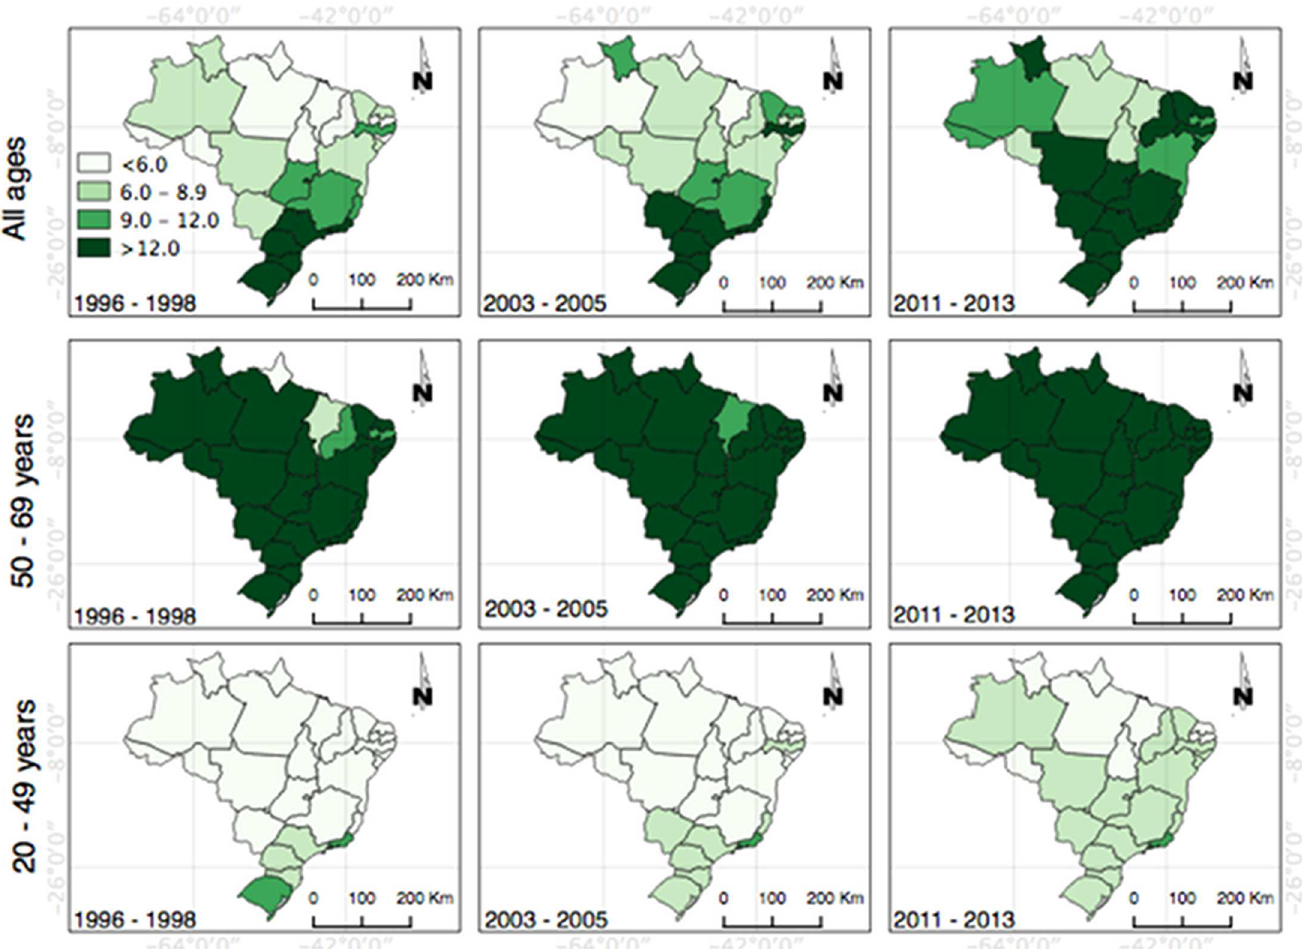
Fig 3. Distribution of the mortality rates from breast cancer in the Brazilian States. (A) Representsthe thematic map of Brazil by regions and States and shows the distributionof the generalmortality rates and age groups 20–49years and 50–69 years in three-yearperiods (1996–1198, 2003–2005and